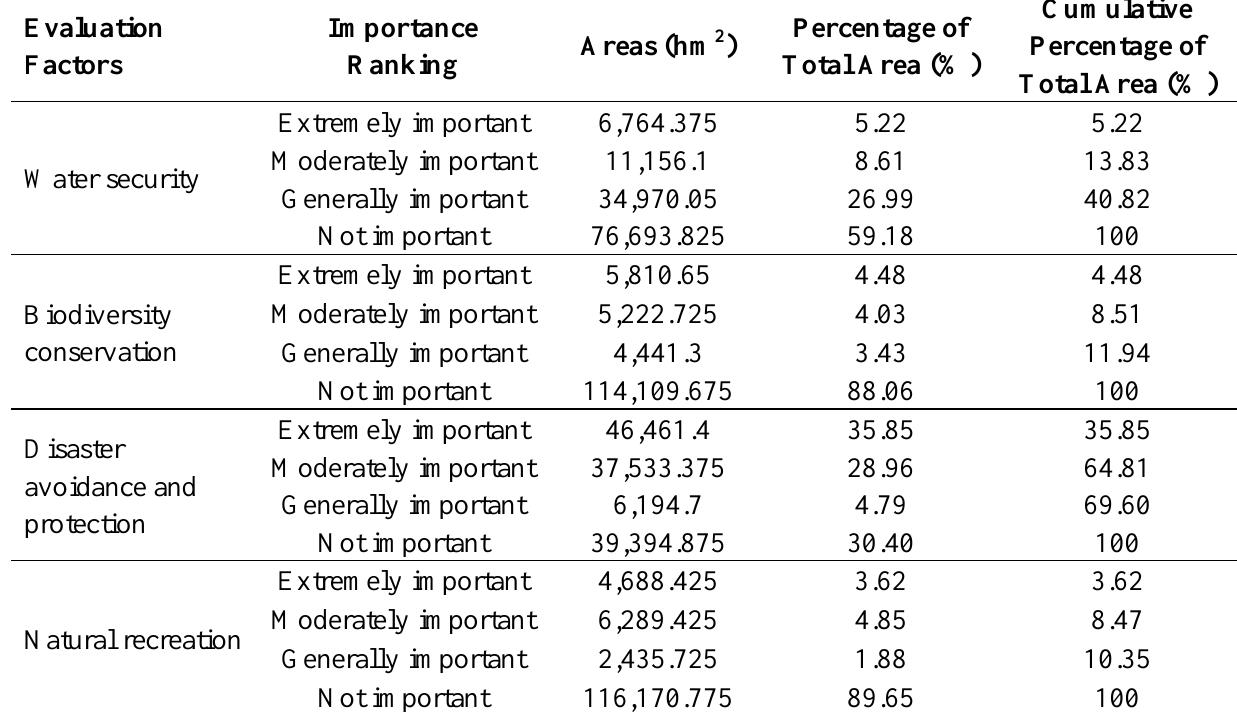
Table 5. Results of the importance evaluations of eco-space in Lanzhou